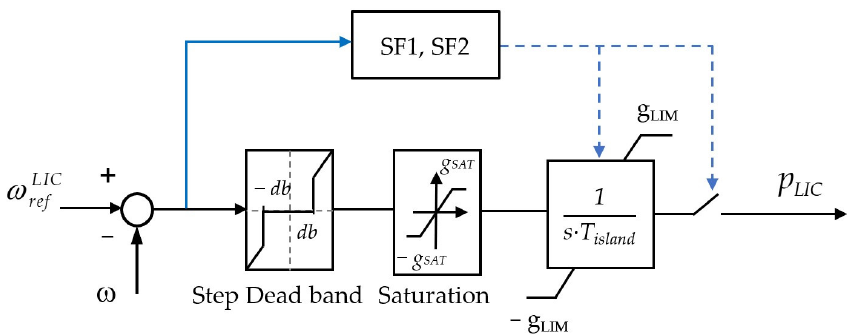
Figure 5. Control scheme of the LIC.